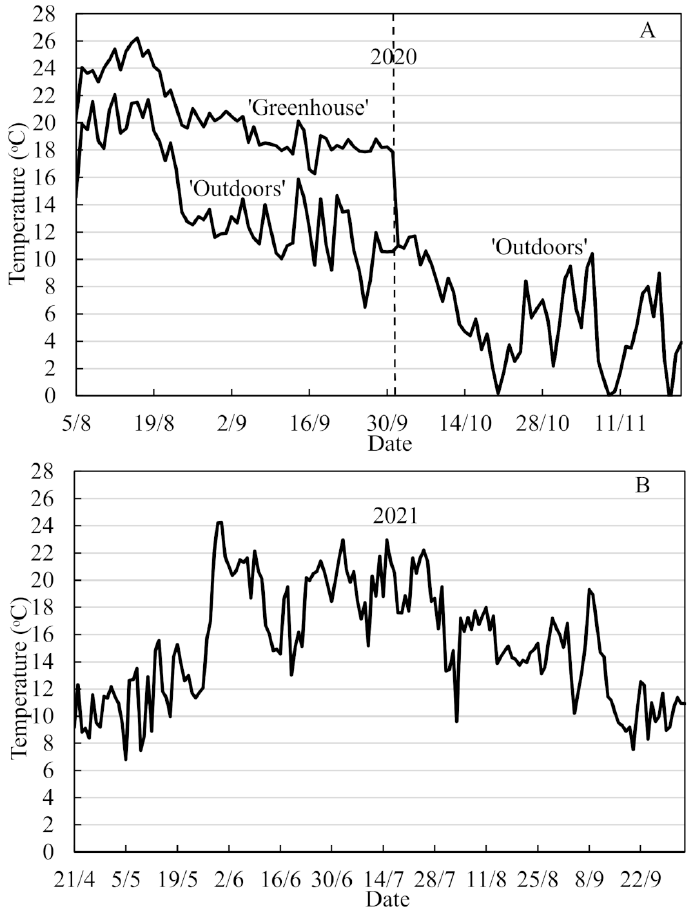
Figure 1. Daily mean temperatures during raising of the plants in 2020 ( A ) and during cropping in the plastic tunnel in 2021 ( B